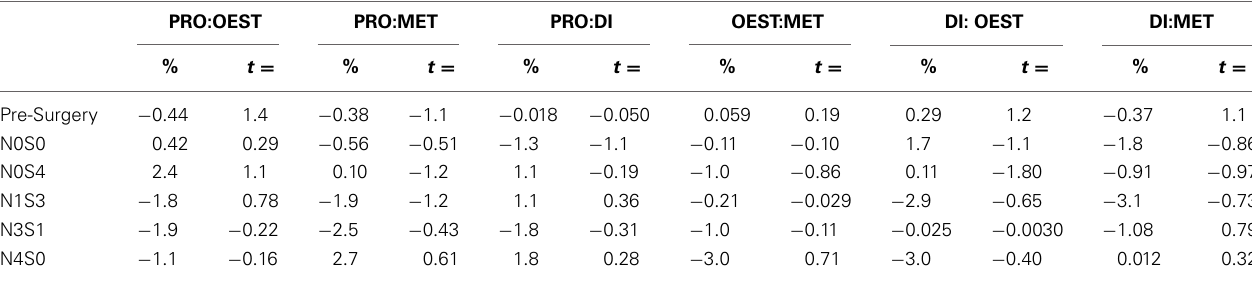
Table 5 | Examining the estimate of the slope of the linear relationship between the response and von Frey filament for von Frey Test 2 revealed the absence of an oestrus cycle effect across all surgery